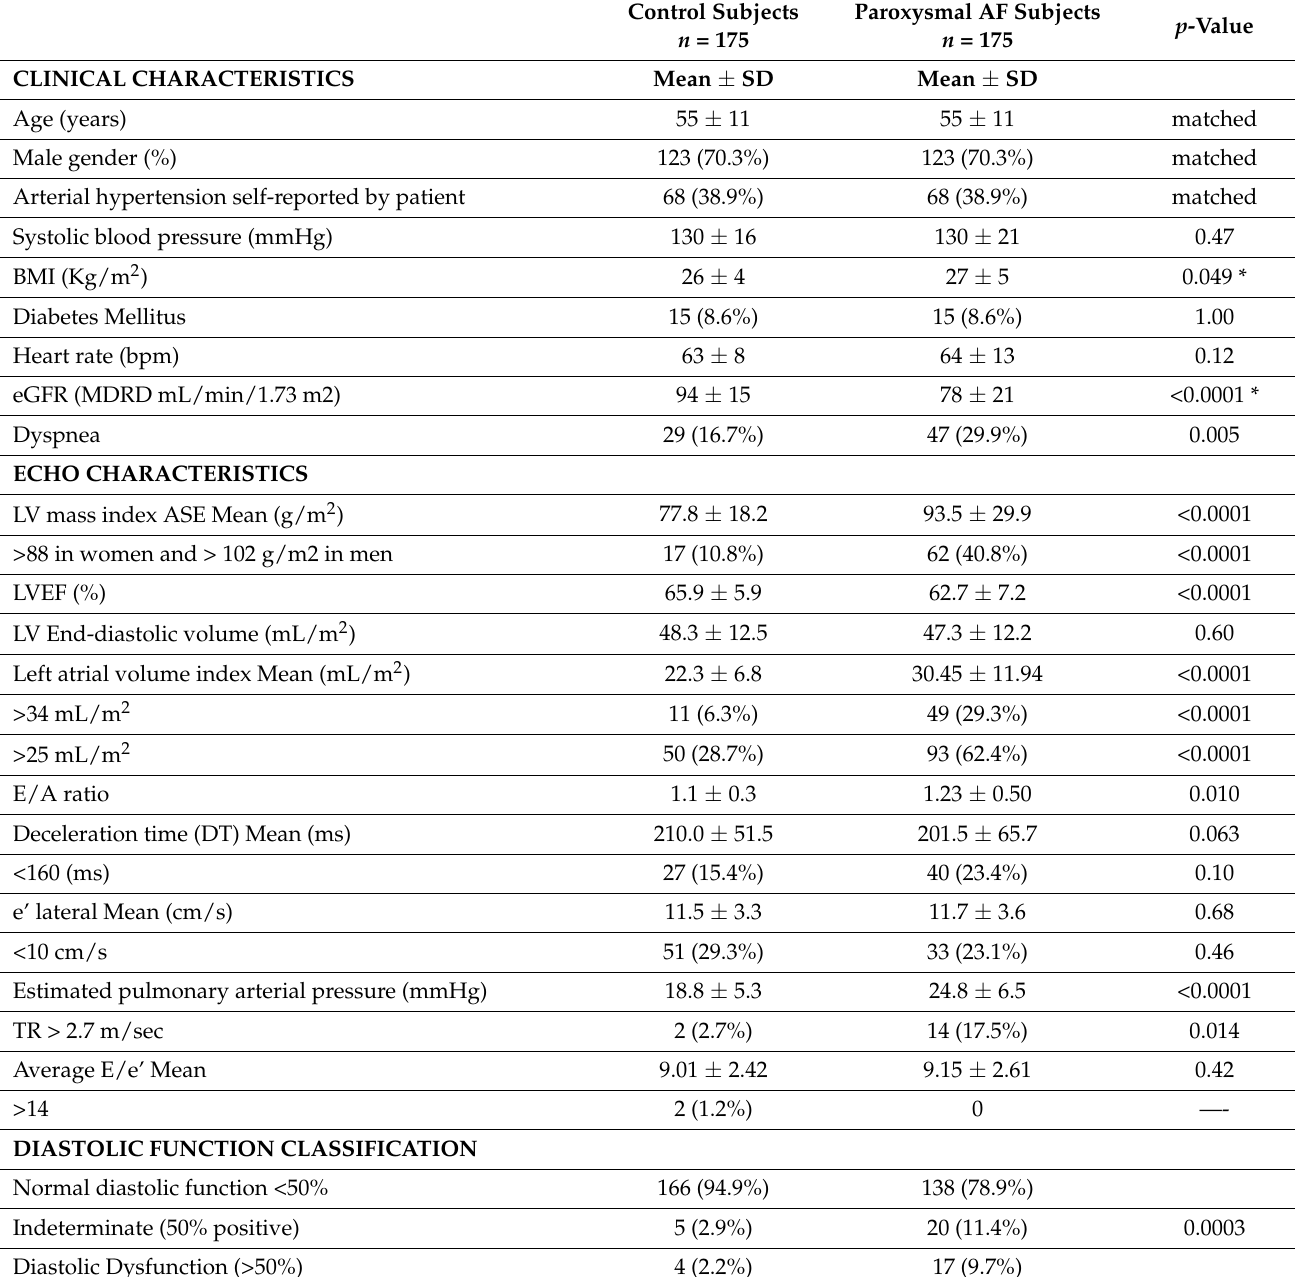
Table 2. Clinical and echocardiographic characteristics of controls and patients with paroxysmal atrial fibrillation. Control